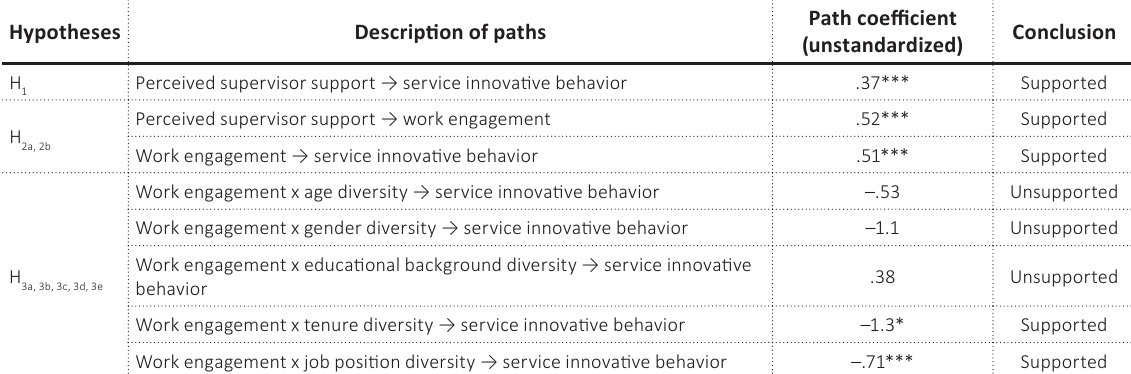
Table 3. Structural equation modeling